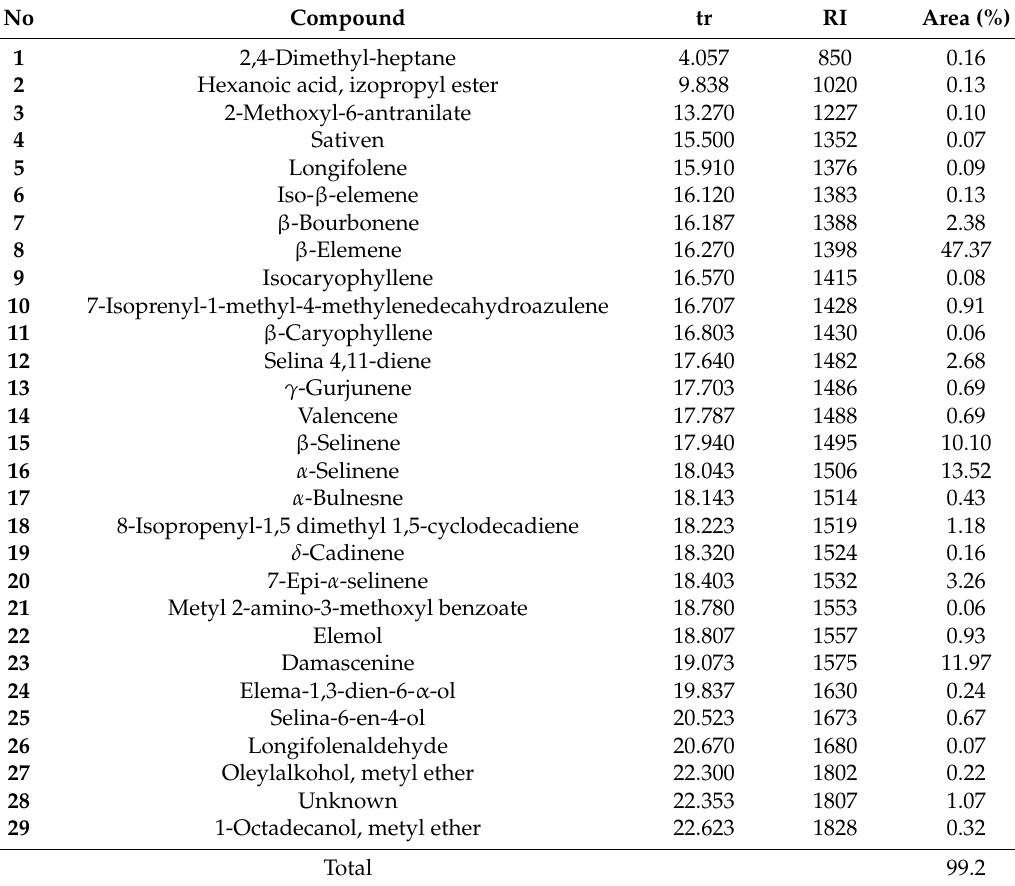
Table 1. The chemical composition of N. damascena L. essential